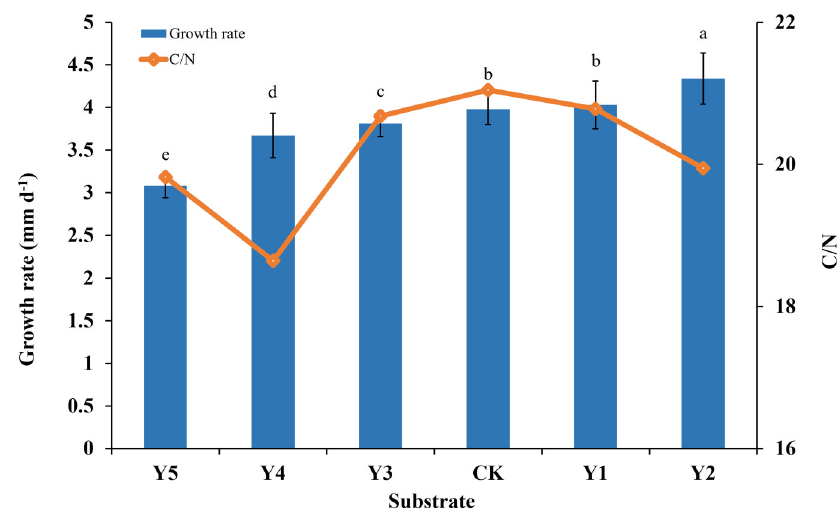
Figure 2. Effect of different substrates on the C:N rate and mycelial growth rate of P. eryngii .